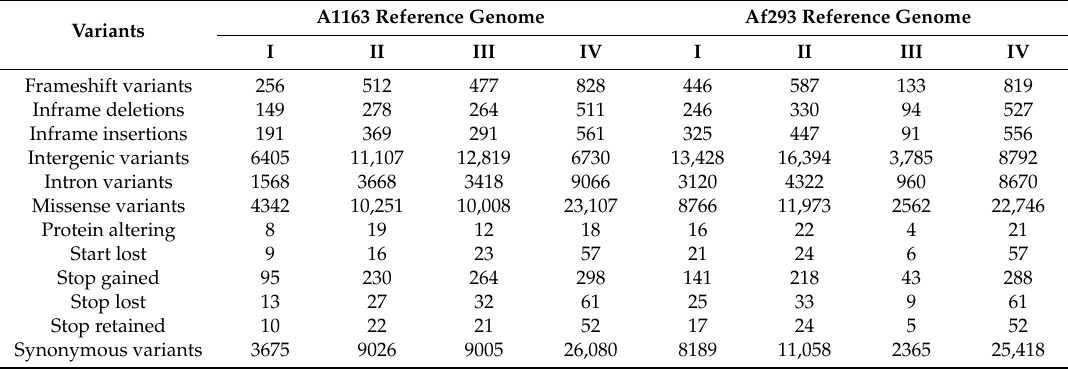
Table 5. Types of SNVs and features. Variants found within each cluster compared to both